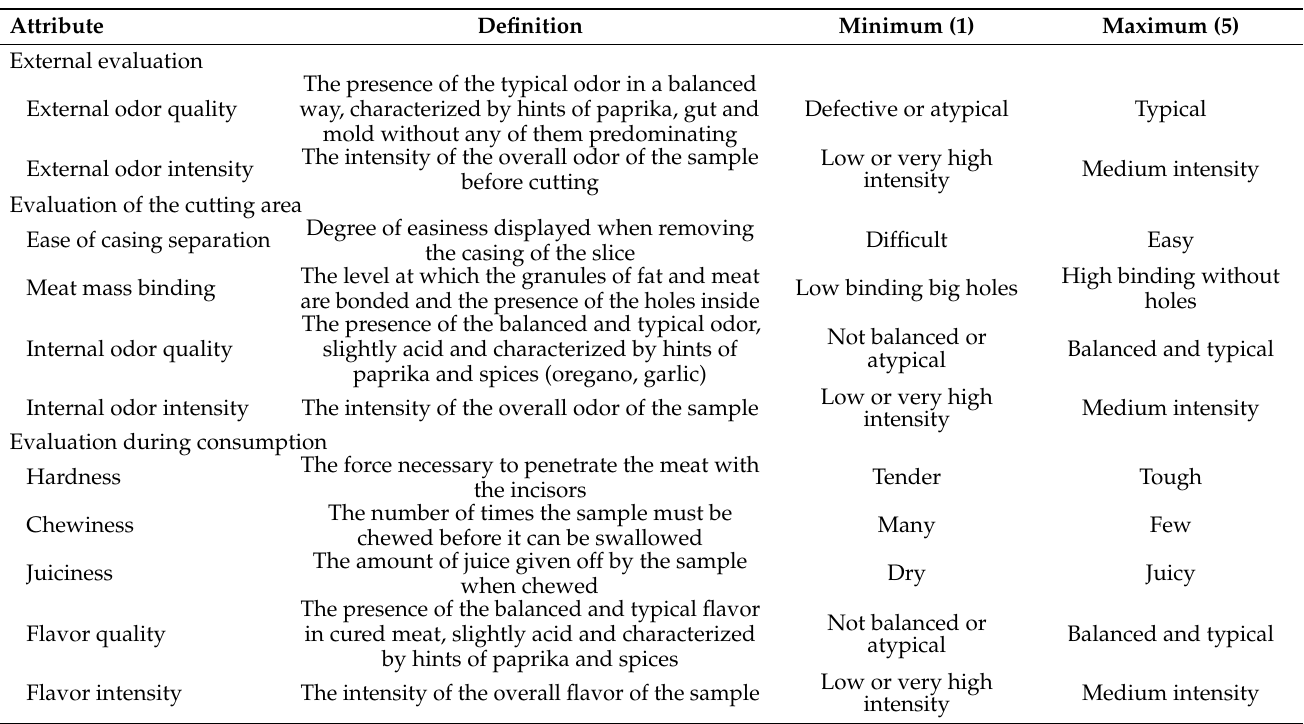
Table 1. The sensory card used in the evaluation of dry-fermented sausages of the “Chorizo Zamorano” quality